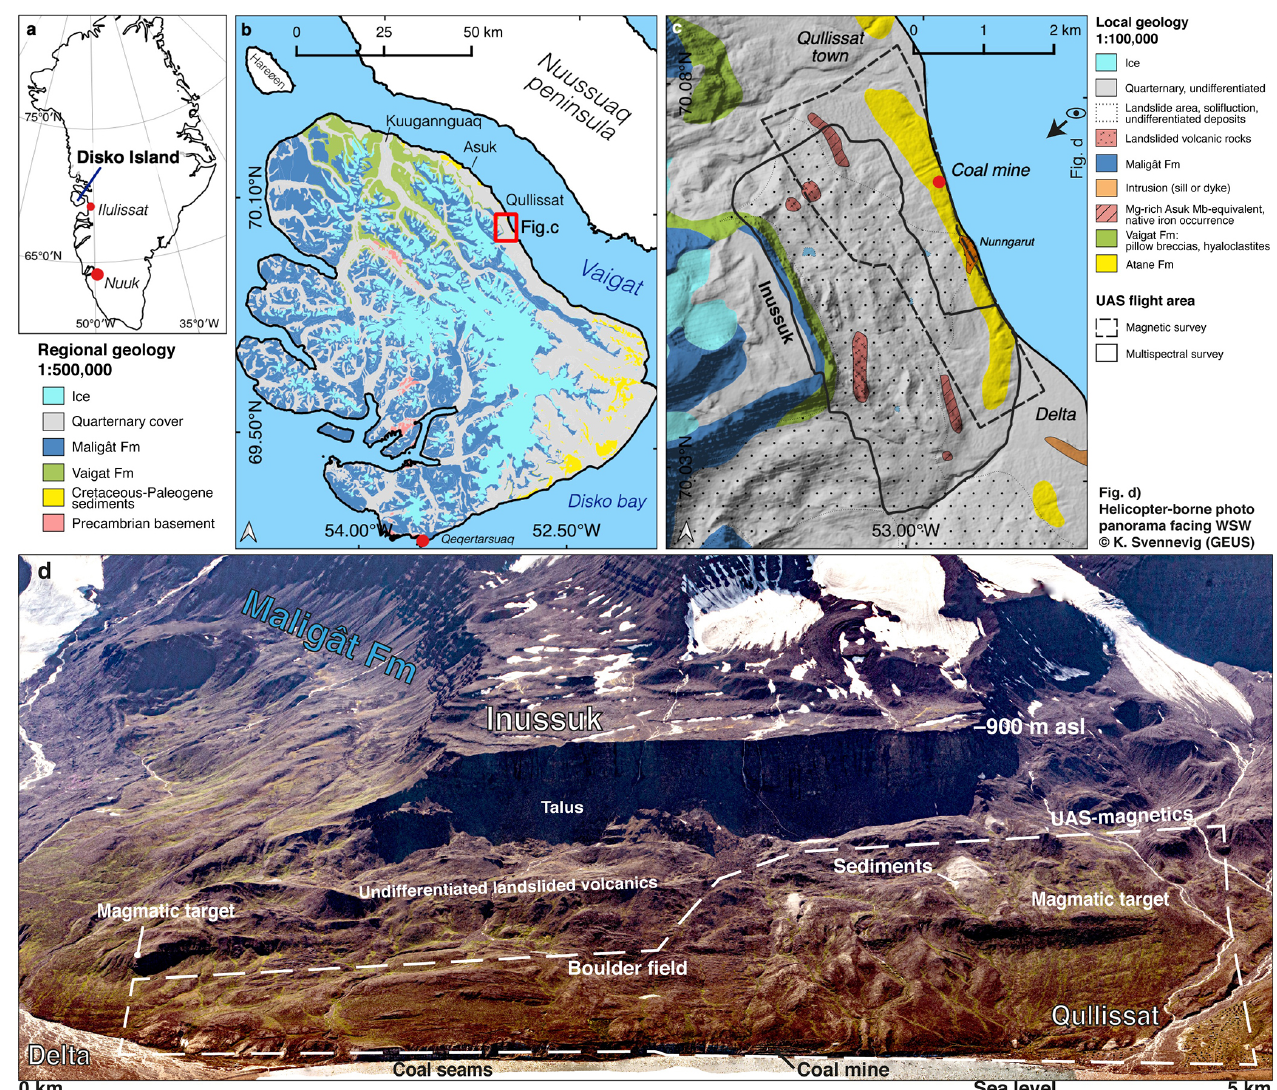
Figure 1. General overview of the study area on northern Disko in West Greenland. (a) The Qullissat study area is located about 125km NW of the village Ilulissat. (b) Regional geological map from Disko Island with the Palaeogene basaltic Maligât and Vaigat formations, which are emplaced in a Cretaceous sediment basin and incised deeply by glacial erosion. (c) Geological map of the survey site from this study at Qullissat (modified after Pedersen et al., 2013). (d) Oblique overview of the study area based on stitched helicopter-based RGB photographs. The horizontal distance at coast level is about 5km and the Inussuk plateau is located at ∼ 900ma.s.l.